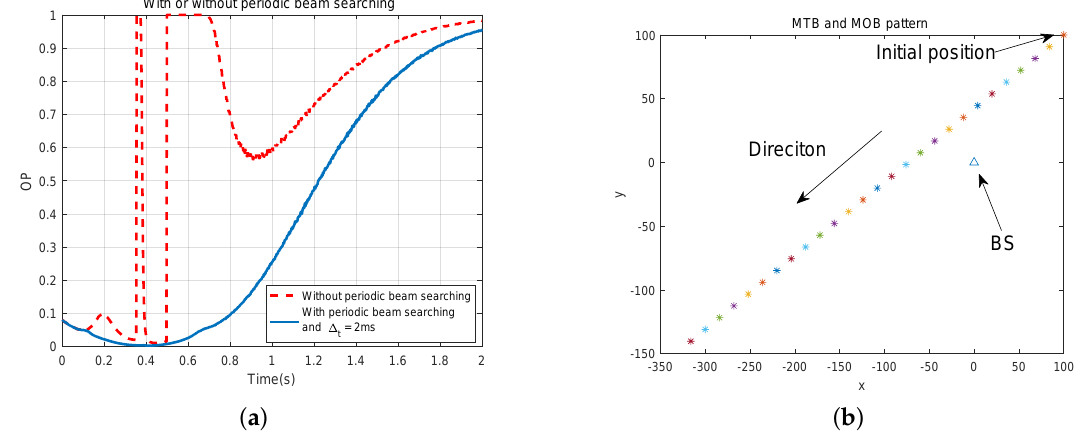
Figure 4. The influence of periodic beam-searching and motion pattern. ( a ) Effect of periodic beam-searching on OP; ( b ) Position